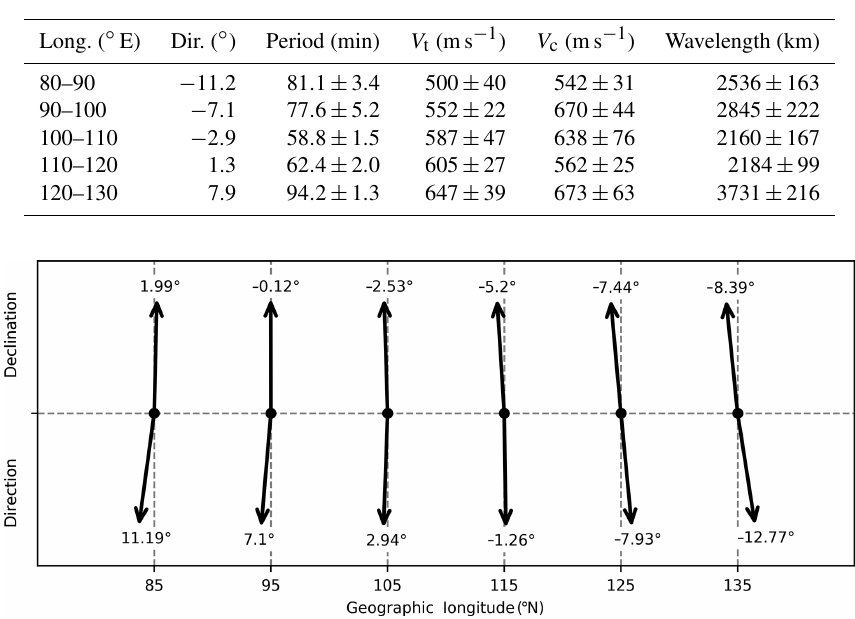
Table 1. The estimated propagation parameters of the LSTID and the corresponding standard errors. The second column contains the propagation directions, which are measured clockwise from the south. V t and V c represent the speed estimated with a certain wave trough and crest. Dir. stands for direction.